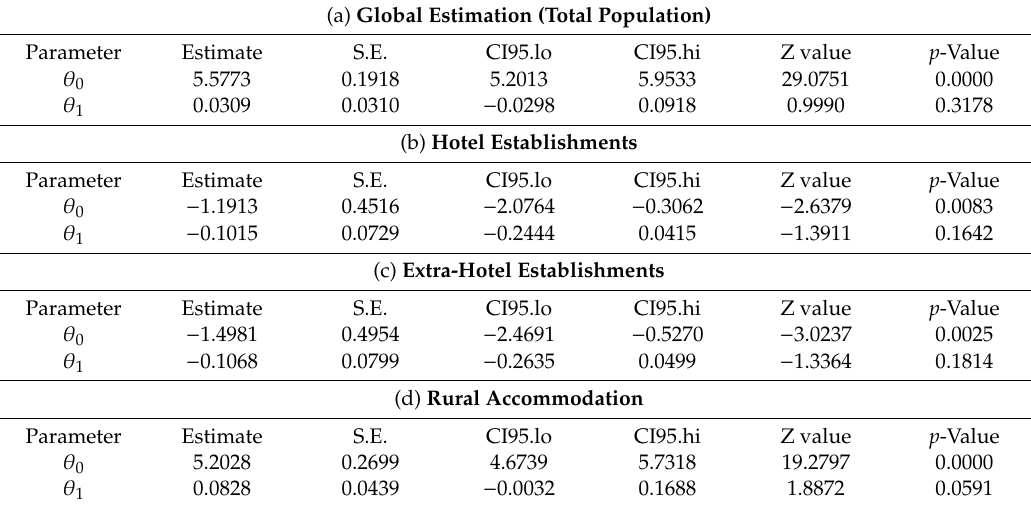
Table 3. Estimation of model (2) λ ( u ,x ) = exp ( θ 0 + θ 1 x ) .